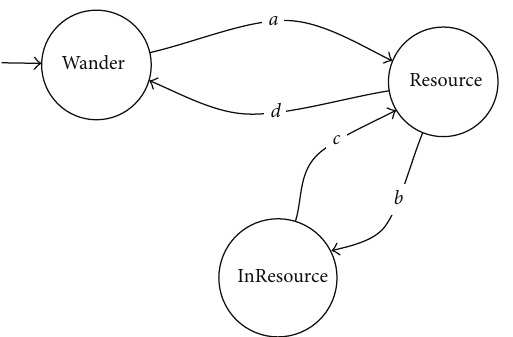
Figure 1: Finite state machine (FSM) that governs the operation of each agent. The initial state is Wander. The transition a is triggered when the agent’s visual sensor detects an oil slick. Transition b occurs when the amount of oil detected is > 80% of the image. Transition c is triggered when the amount of oil is ≤ 80% of the image. Finally, transition d is triggered if no oil is